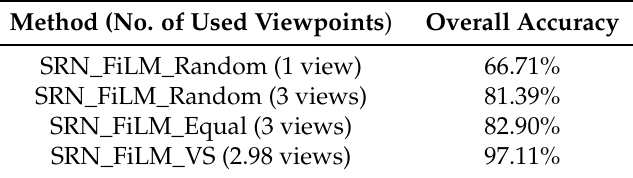
Figure 5. Example results of SRN_FiLM_VS for the Multi-view-CLEVR_12views_ CG dataset. The default view and selected view images are highlighted in red bounding boxes. The incorrect answers are shown in red. Table 3. Effect of viewpoint selection on